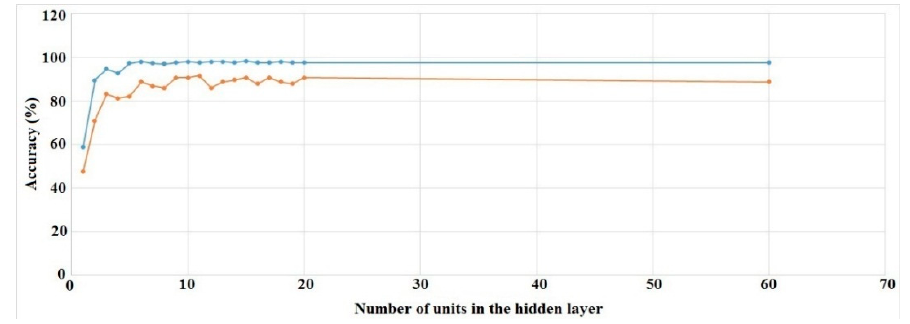
Figure 10. ANN training (blue) and validation set (red) accuracies for different number of units in the hidden layer (RH, generalized). Sensors 2016 , 16 , 605